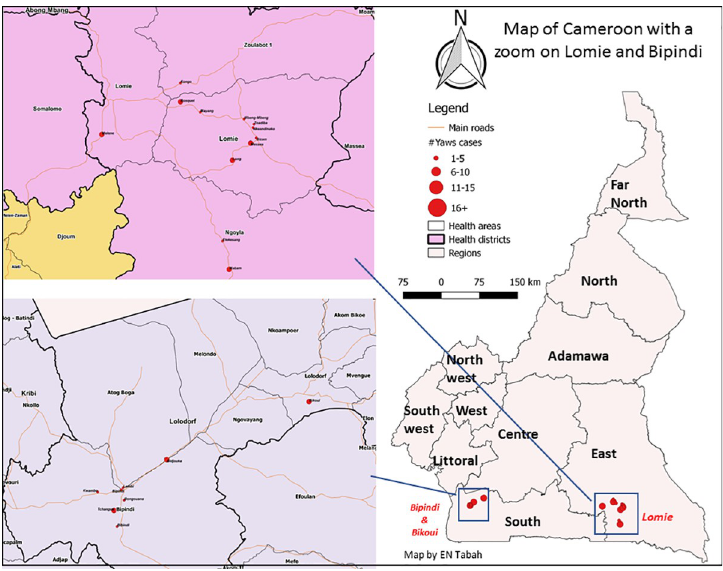
Fig 1. Geographic location of sampling sites. Samples were collected from lesions by rotating the sterile tip of the swab gently on the base and centre areas of the lesion. The swab type, storage and transport conditions differed between the epidemiological investigations. During the first outbreak, flocked swabs stored in 1 ml Amies transport medium (Eswab, Copan Diagnostics Inc., Brescia, Italy) were used. In the second outbreak, samples were collected us2ing the Abbott m ulti-Collect Specimen Collection Kit (Abbott, Des Plaines, IL, USA) which includes 1.2 mL of specimen transport buffer. During the last investigation, cotton-tipped swabs with wooden shaft (Copan Diagnostics Inc) were used for sample collection and stored dry until use. All samples were transported refrigerated to the Centre Pasteur du Cameroun (CPC) in Yaounde. Samples were stored as received at -20˚C until testing. Blood samples were collected for serology to determine the presence of non-treponemal and treponemal